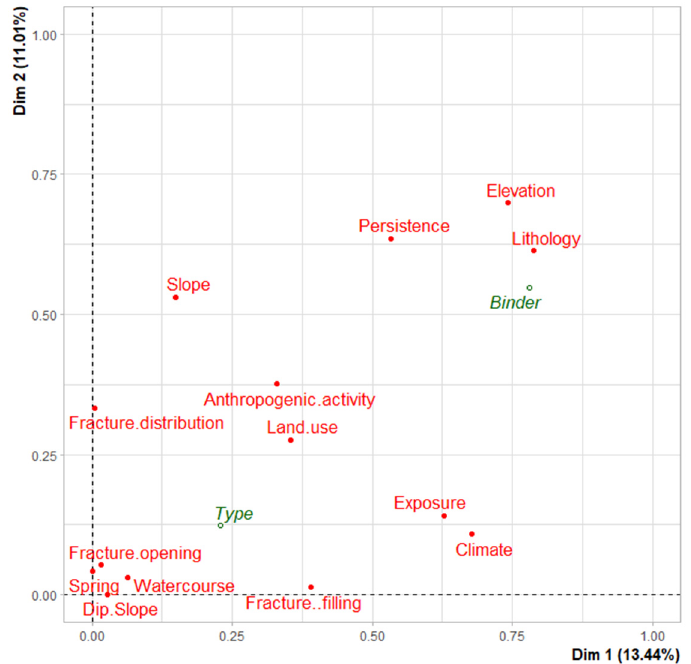
Figure 7. Graph of MCA variables.